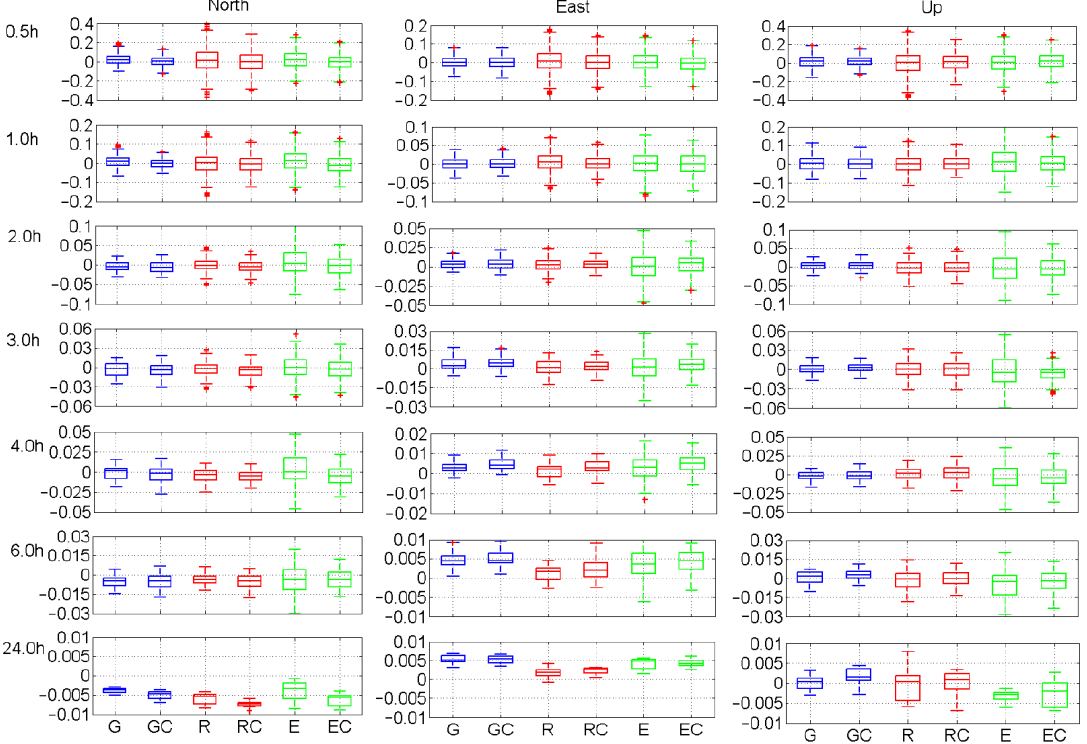
Figure 10. Box whisker plots for time series of position components differences: from 0.5-h session to 24 h session. Please note the different scales on vertical axis.